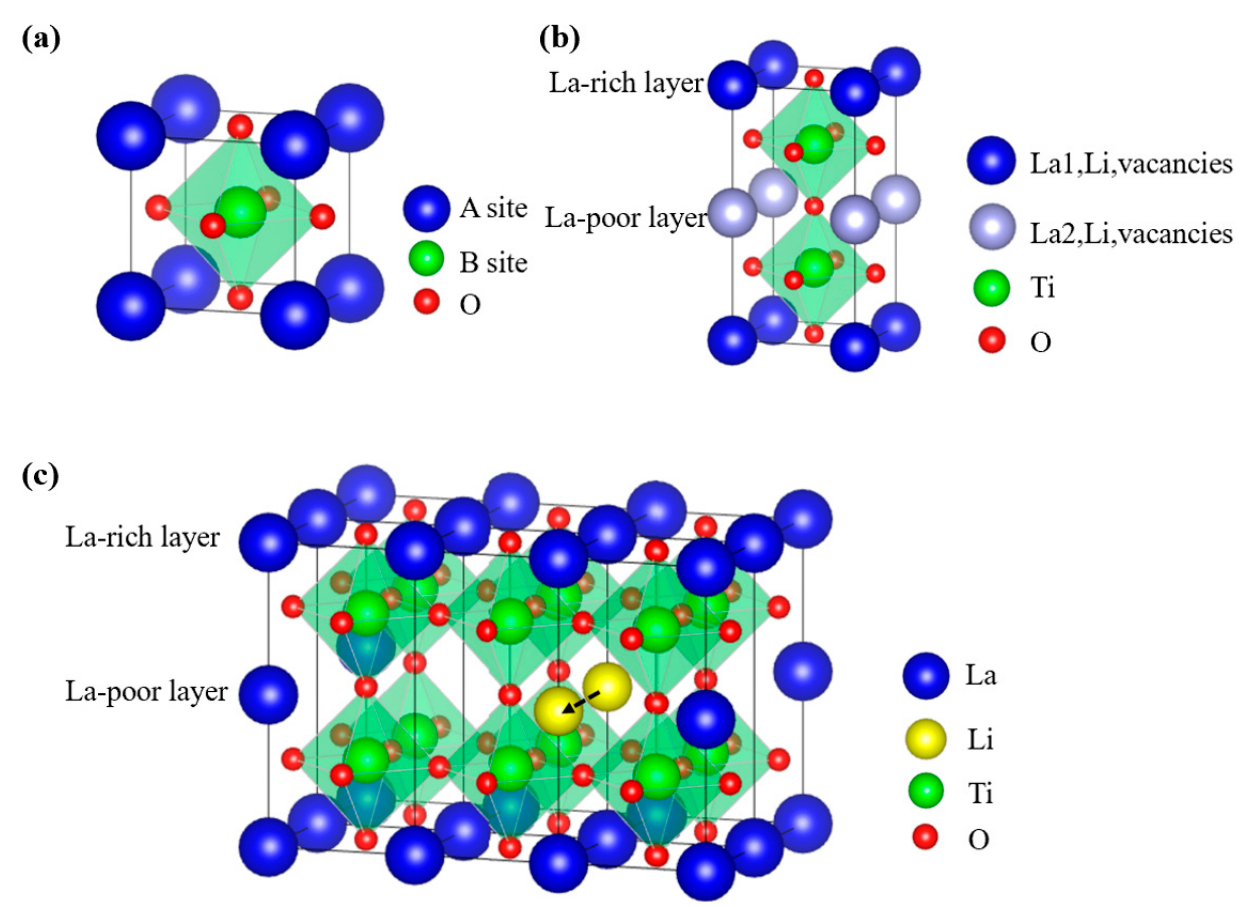
Figure 4. ( a ) ABO 3 structure. ( b ) Crystal structure of LLTO with La-rich and La-poor regions. ( c ) Schematic diagram of the supercell of LLTO and Li pathway.